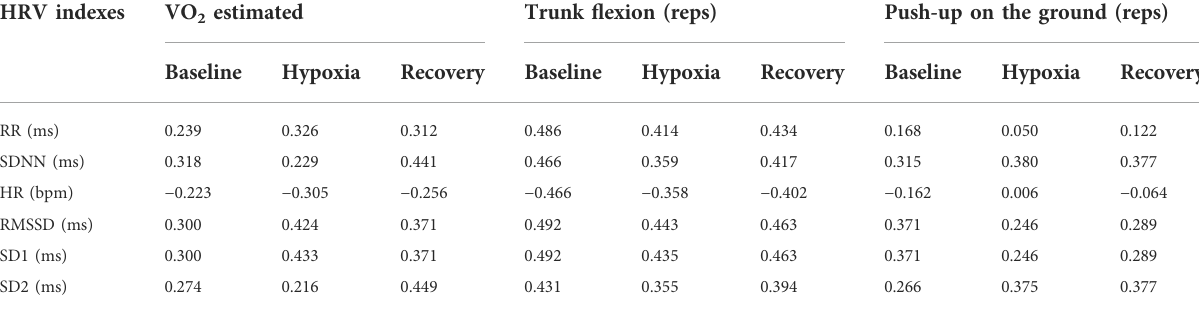
TABLE 3 Spearman correlations between HRV indices at different moments and VO 2 estimated, trunk fl exion (reps), and push-ups on the ground (reps). HRV indexes VO 2 estimated Trunk fl exion (reps) Push-up on the ground (reps) Baseline Hypoxia Recovery Baseline Hypoxia Recovery Baseline Hypoxia